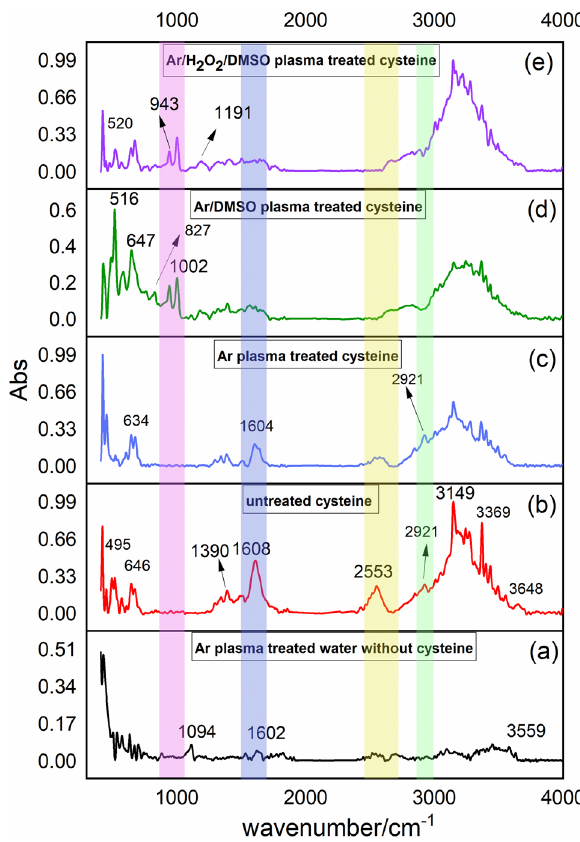
Figure 3. FTIR spectra of ( a ) Ar plasma-treated water without cysteine, ( b ) untreated cysteine solution and plasma-treated cysteine solution by ( c ) Ar plasma, ( d ) Ar + DMSO plasma, and ( e ) Ar + H 2 O 2 + DMSO plasma. (Highlighted regions show appearing or disappearing bonds of (green) C–H, (yellow) S–H, (blue) COO – , (pink) S–S, and